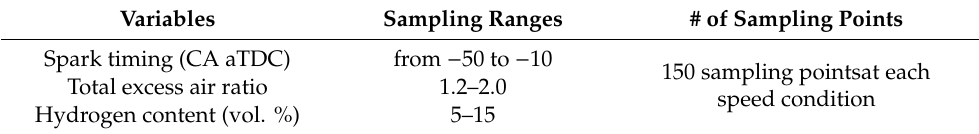
Table 3. Sampling ranges for each variables and the number of sampling points.